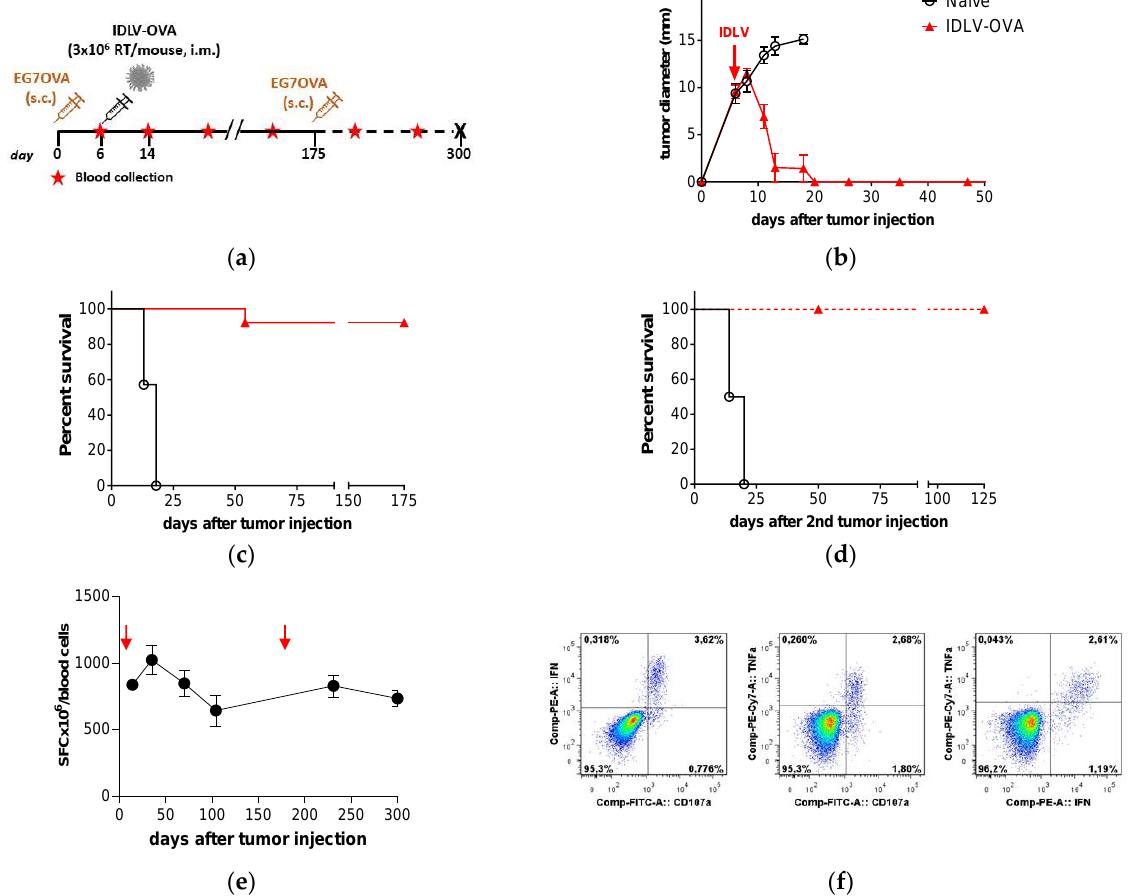
Figure 1. Therapeutic efficacy of integrase-defective lentiviral vectors (IDLV)-ovalbumin (OVA) vaccination in E.G7-OVA- bearing mice. ( a ) Scheme of the experiment: 14 C57BL/6 mice were inoculated s.c. with 3.5 × 10 6 E.G7-OVA cells/mouse. Mice with 7–9 mm diameter tumor mass were vaccinated with 3 × 10 6 RT/mouse of IDLV-OVA ( n = 7) or left untreated (Naïve, n = 7). Tumor growth, survival, and immune response were monitored over time. Tumor-free mice were injected a second time with tumor cells at 175 days and monitored up to the end of the experiment (300 days). ( b ) Tumor growth after the first tumor injection is shown. Mice were sacrificed when the tumor diameter reached 15 mm or an ulceration of tumor was observed. ( c , d ) Kaplan–Meier survival curves are shown. Survival was monitored up to 175 days after the first tumor injection (Log-rank Mantel-Cox test) and up to 125 days from the second tumor injection (Log-rank Mantel-Cox test). ( e ) Kinetics of OVA-specific T cell response in IDLV-OVA vaccinated mice, after E.G7-OVA injection (red arrows). Blood cells were collected at the indicated time points and stimulated with the H-2Kb restricted OVA 8mer peptide (SI- INFEKL). Data are expressed as specific spot forming cells (SFC) per 10 6 cells. Error bars indicate the standard deviation among the animals from the same group. ( f ) Polyfunctional OVA-specific CD8+ T cells. Vaccinated and tumor-free mice were sacrificed at 300 days and splenocytes were used to evaluate the magnitude and quality of OVA-specific CD8+ T cell response by intracellular cytokine staining (ICS). A representative experiment is shown. CD8+ T cells were analyzed in splenocytes stimulated with OVA 8mer peptide (OVApep). The percentage of CD8+ T cells producing IFNγ and TNFα and expressing CD107a is indicated within the quadrants.